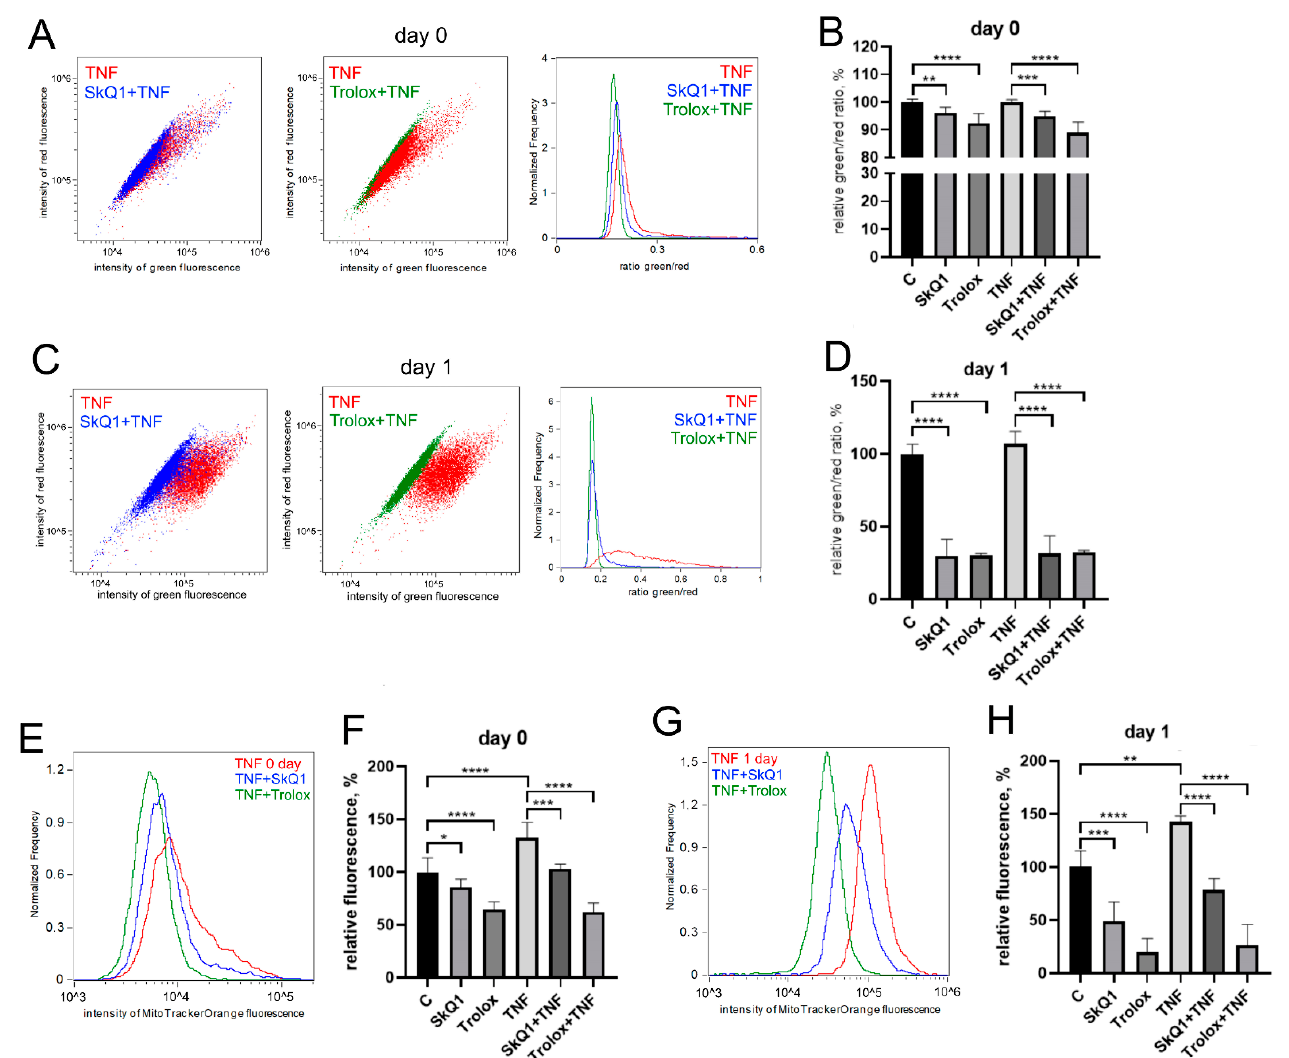
Figure 3. Antioxidants decrease the level of mitoROS and mitochondrial lipid peroxidation in differentiating myoblasts. Cells were treated with 50 ng/mL TNF 24 h before the induction of differentiation. SkQ1 (40 nM) and Trolox (100 µ M) antioxidants were added 48 h before TNF and then again into the differentiation medium. Mitochondrial lipid peroxidation was measured by flow cytometry with the MitoCLox ratiometric probe ( A – D ); mitoROS levels ( E , F ) were measured by flow cytometry with the MitoTracker Orange CM-H2TMRos probe before (Day 0) and 24 h (Day 1) post differentiation induction in control and TNF-treated myoblasts. ( C , D ) Mitochondrial lipid peroxidation. ( A , C , E , G ) show typical flow cytometry histograms and scatter plots. ( B , D , F , H ) show mean values of the ratios of median green and red fluorescence intensity ± SD (*— p < 0.05, **— p < 0.01, ***— p < 0.001, ****— p < 0.0001, n ≥ 3). Data are presented as % relative to untreated